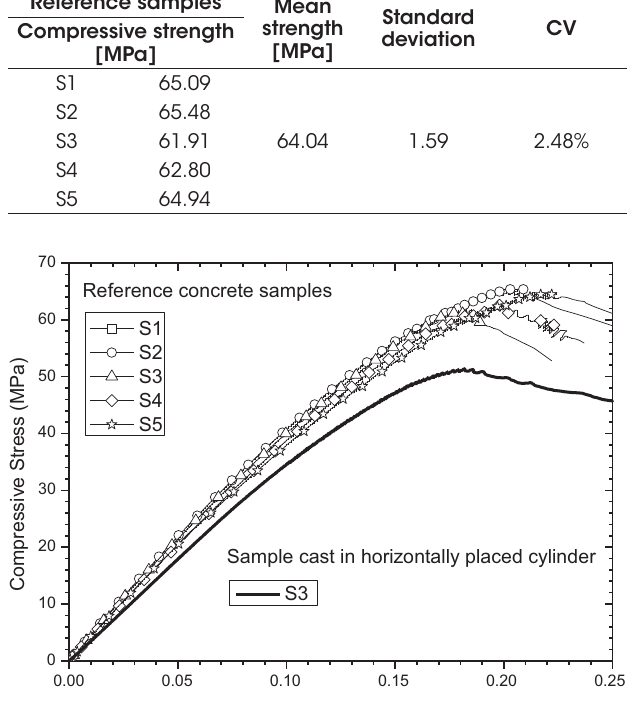
Sample cast in horizontally placed